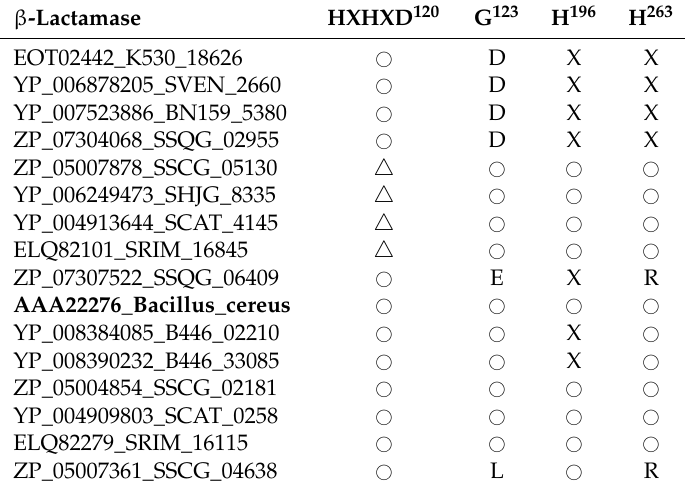
Table 4. Presence or absence of active site residues in class B β -lactamases. β